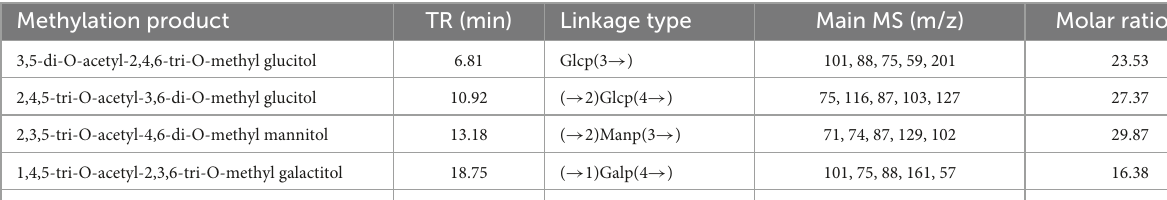
TABLE 1 GC–MS analysis for methylation experiments of PKP2-1.